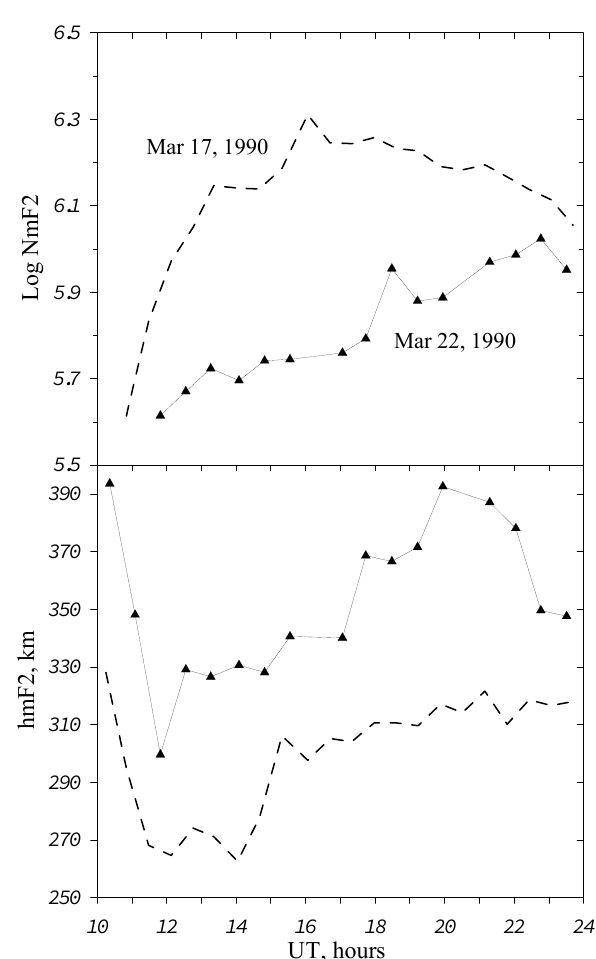
Fig. 6. A pronounced negative F2-layer storm event observed at Millstone Hill on 22 March 1990; a reference quiet day of 17 March 1990 is given for a comparison. Note that disturbed hm F2 are much higher than the reference ones for all daytime